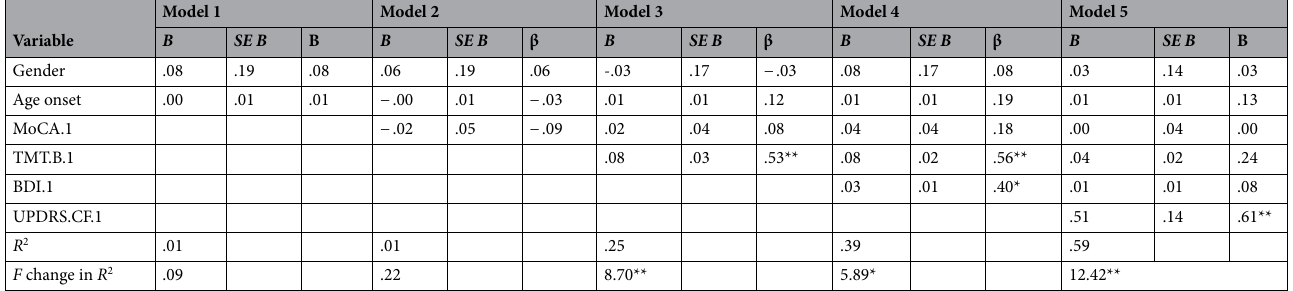
Table 5. Prediction of Follow-Up DLQ.A.2 Score by gender, age onset, the MoCA.1, TMT.A.1, TMT.B.1, BDI.1, and UPDRS-CF.1 Feature. * p < .05, ** p < .01, *** p < .001.